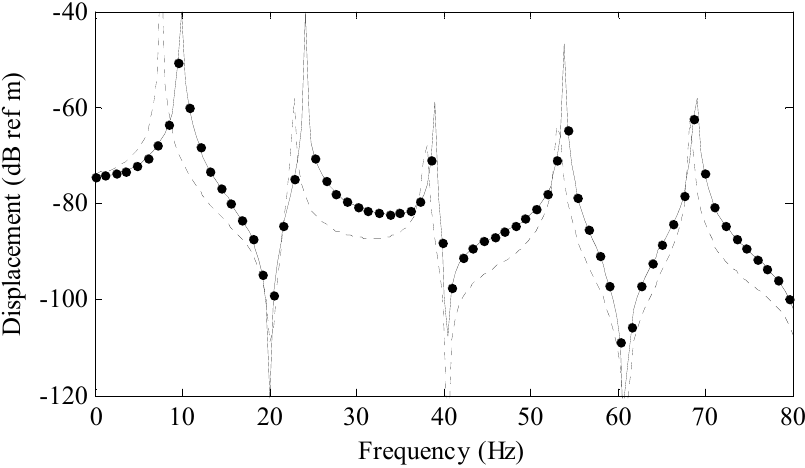
Figure 2. Displacement versus frequency for a rod with a linear variation of cross-sectional area. The solid line is the series solution, the circular markers are the analytical solution and the dashed line is the baseline model with uniform cross-sectional area.